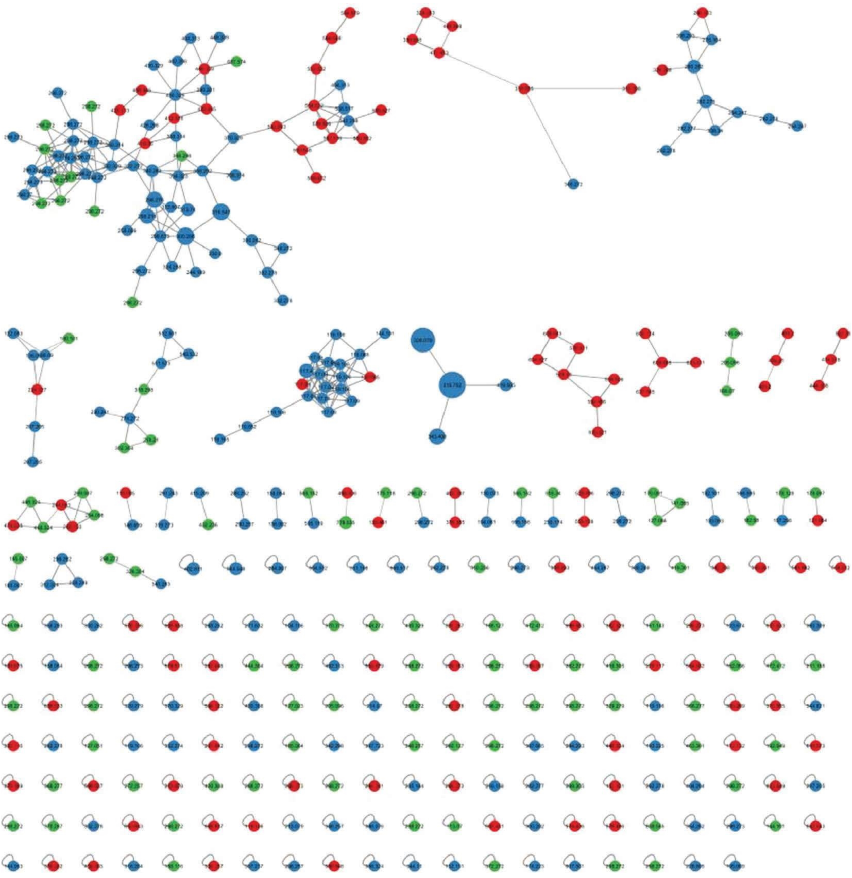
Figure 3: Molecular networking of the compounds from the ethanolic and water extracts of C. spectabilis